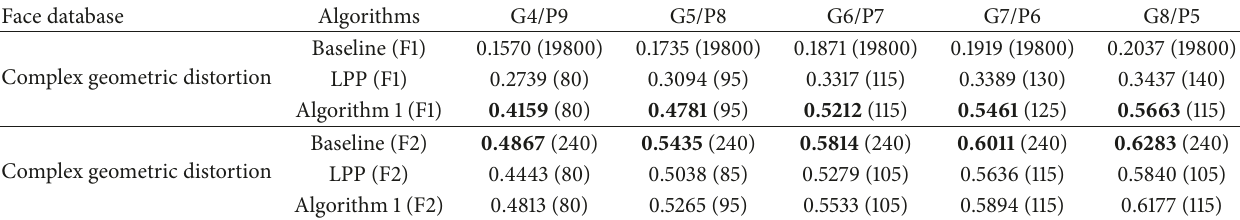
Table 6: The recognition rates on complex geometric distortion AR face database over “F1” and “F2” features; recognition rates (dimensionality).